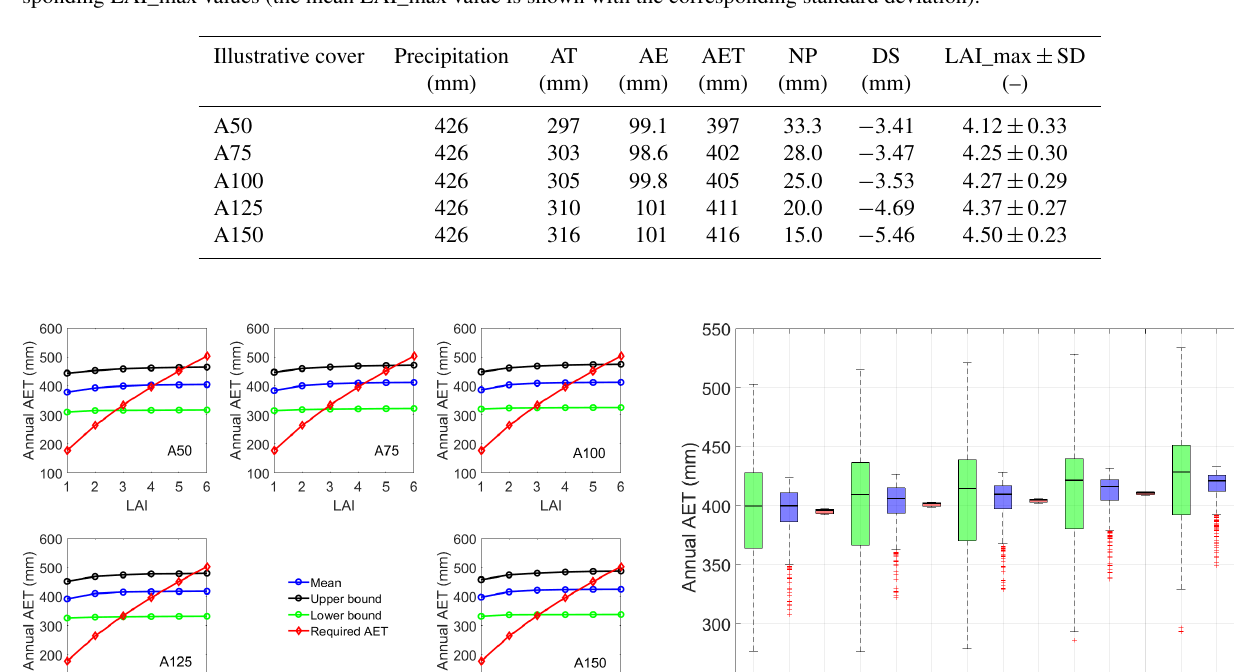
Table 4. Summary of water balance components for the five illustrative covers obtained using 700 sampled parameter sets with the corre- sponding LAI_max values (the mean LAI_max value is shown with the corresponding standard deviation).